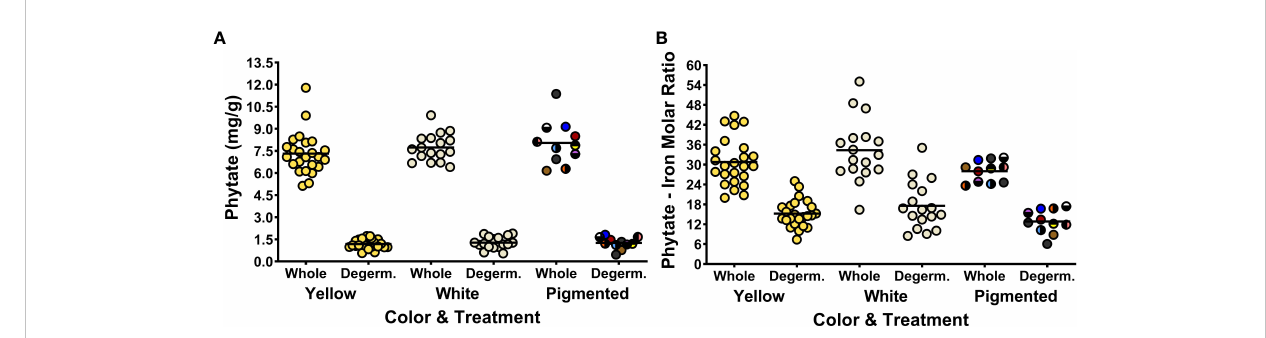
FIGURE 2 Dot plots depicting phytate concentrations (A) and phytate:Fe molar ratios (B) of the 52 maize genotypes in the Maize Nutrition Panel before (whole) and after removing the germ fraction (degerminated). Each dot represents the mean value of two measurements from each genotype. Phytate concentrations are measured as milligrams per gram of cooked, lyophilized and milled maize sample (dry weight). The circle color of pigmented maize represents the bran color pattern of each